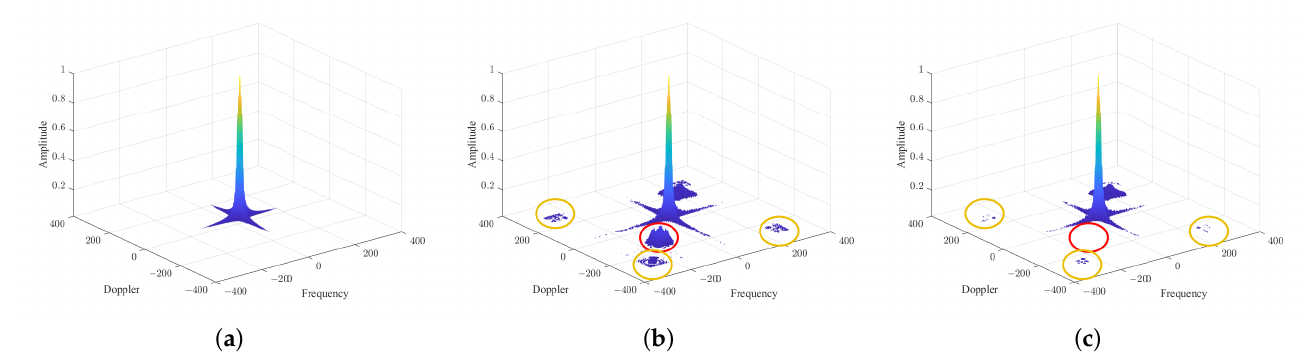
Figure 6. The three-dimensional spectrum of a wideband signal with a high oversampling rate set to 20. ( a ) Results with high-precision quantization. ( b ) Results with one-bit quantization. ( c ) Results with the proposed two-bit quantization.